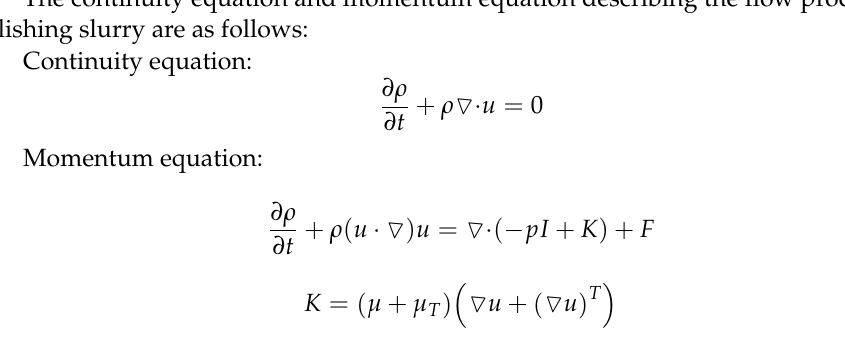
Figure 4. CMP model geometric structure diagram.